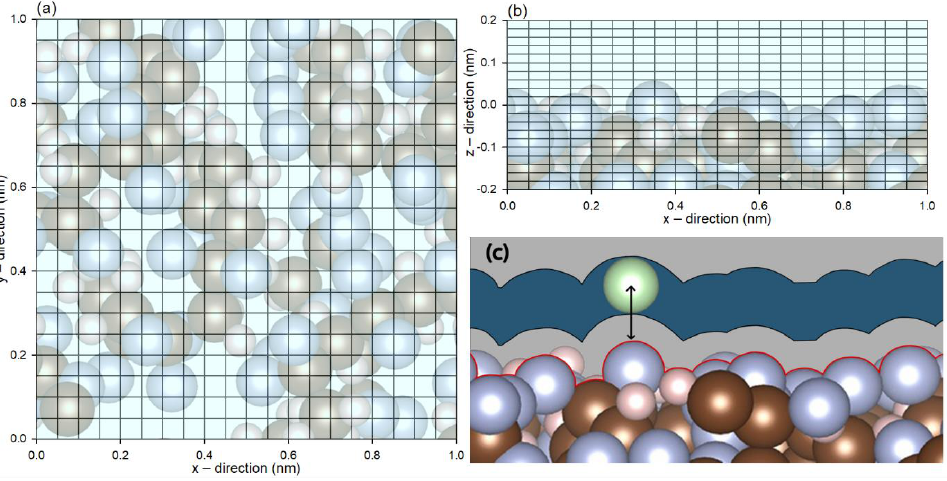
Figure 1. Coordinates of the probing molecules in the lattice spacing from the ( a ) top and ( b ) side views. ( c ) Schematic diagram of the distance between a probing molecule and the membrane.